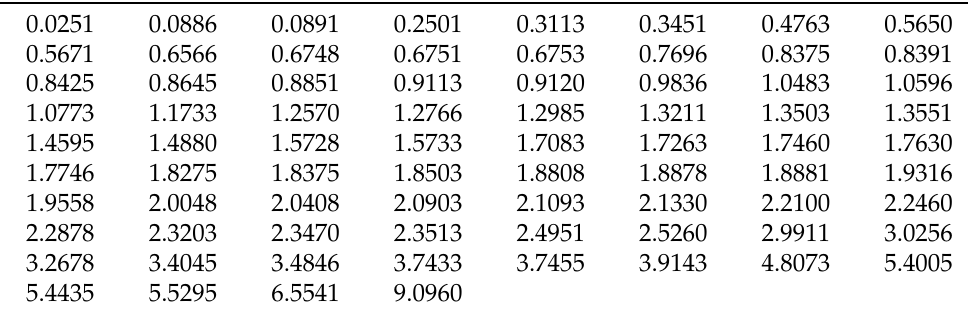
Table 2. Data corresponding to the real application.